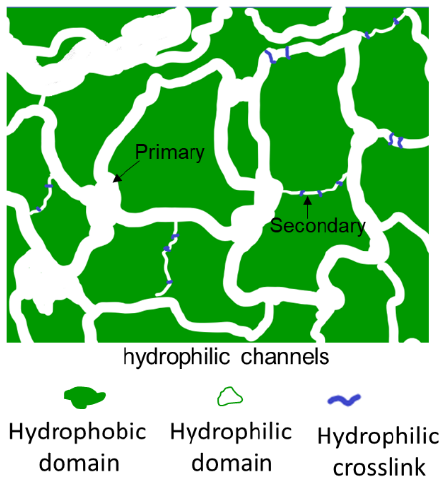
Figure 1. Schematic illustration showing the secondary hydrophilic channels (“waterway canals”) made possible by the hydrophilic covalent cross-linking of the diblock ionomers.